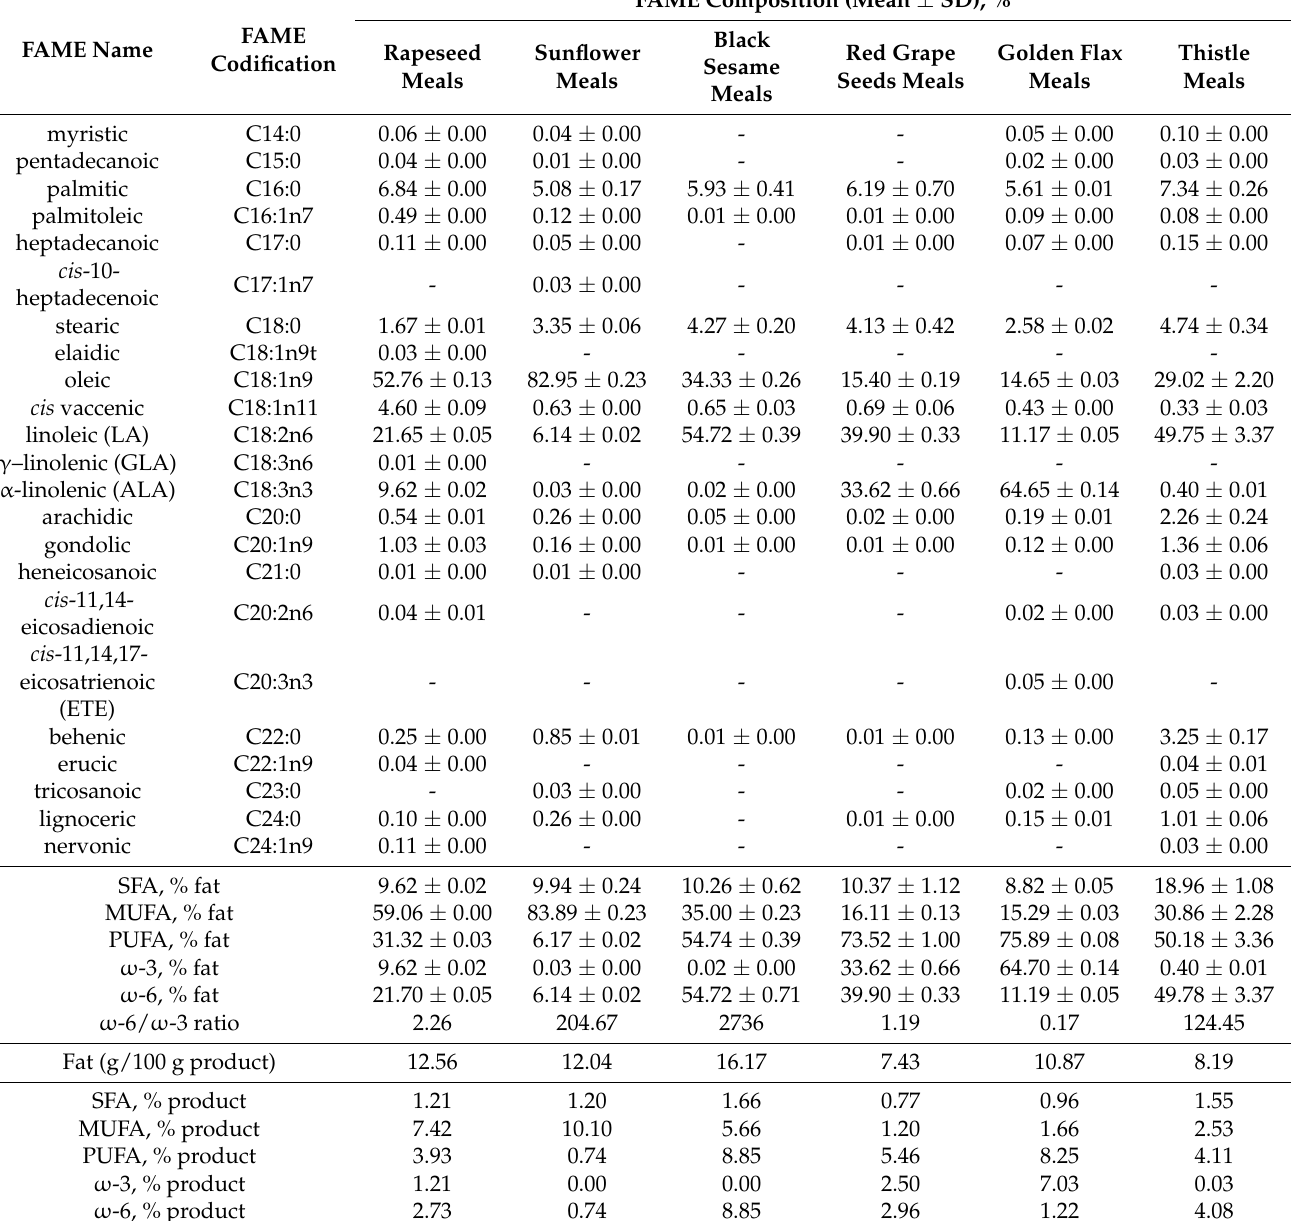
Table 3. Fatty acid methyl esters content of meal